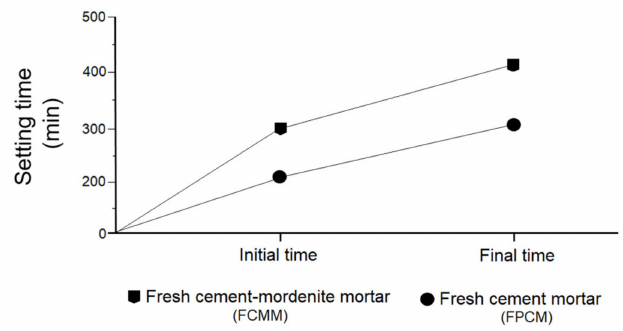
Figure 9. Initial and final times of settings.